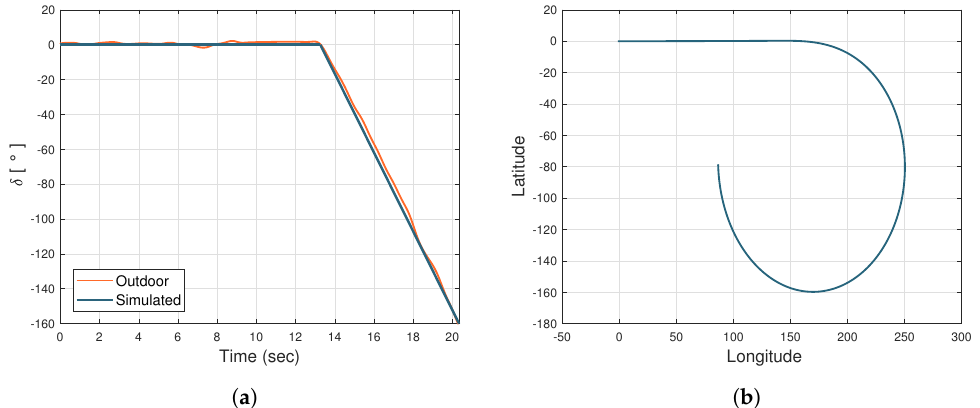
Figure 15. Example of lateral manoeuvres’ input reproduction. ( a ) Experimental and reproduced steering angle comparison. ( b ) Slow ramp steer trajectory in simulation environment.